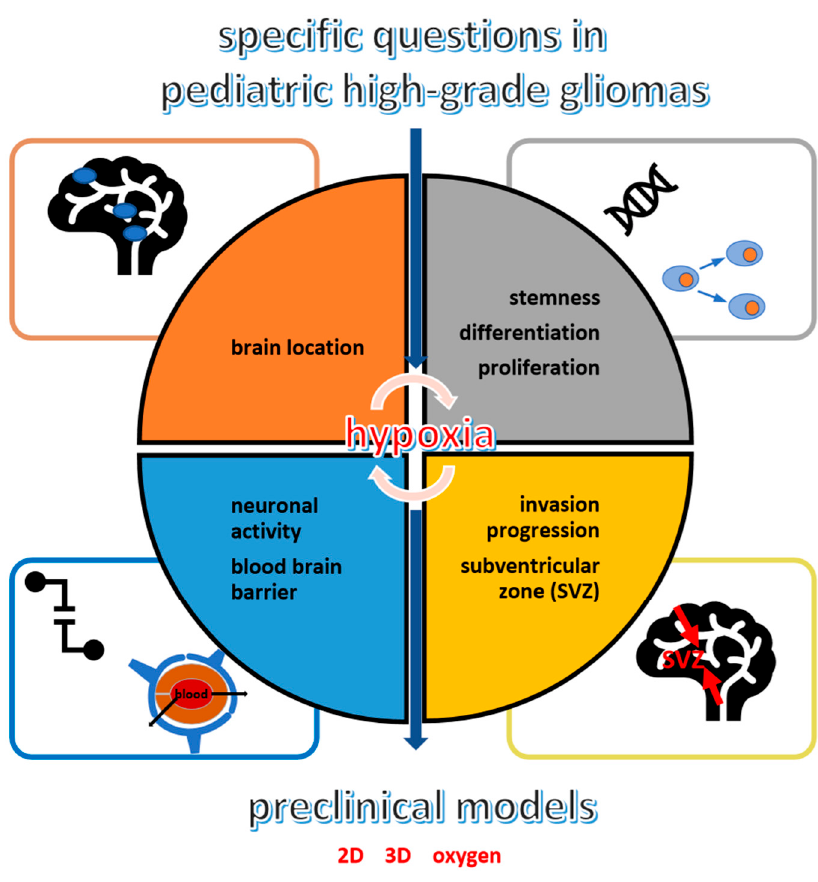
Figure 1. Specific questions on pediatric high-grade gliomas (pHGGs): hypoxia links with locations (orange), cell properties (grey), propensity to migrate especially from and in a subventricular zone (SVZ) (yellow) and the neuronal / blood–brain barrier environment (blue).